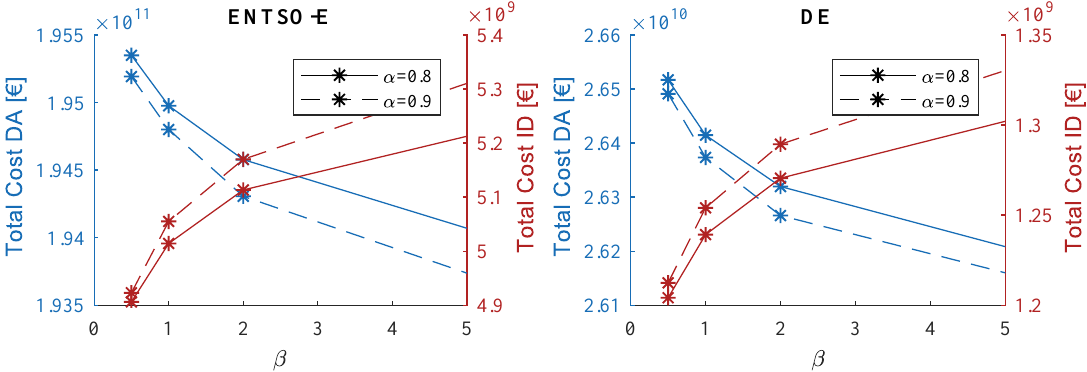
Figure 11. Total cost of electricity generation on DA and ID for ENTSO-E ( left ) and Germany ( right